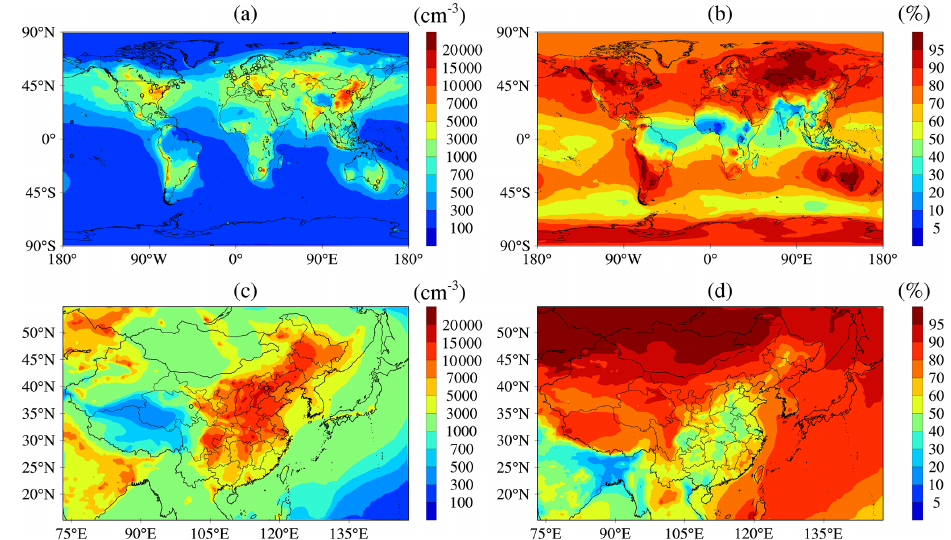
Figure 7. Surface layer horizontal spatial distributions of annual mean number concentrations of CN10 (a, c) and fraction of CN10 that is secondary (b, d) over the first domain (a, b) and second domain (c, d) . Observed CN10 values in Table S1 are also overlapped with shaded circles on the plots for